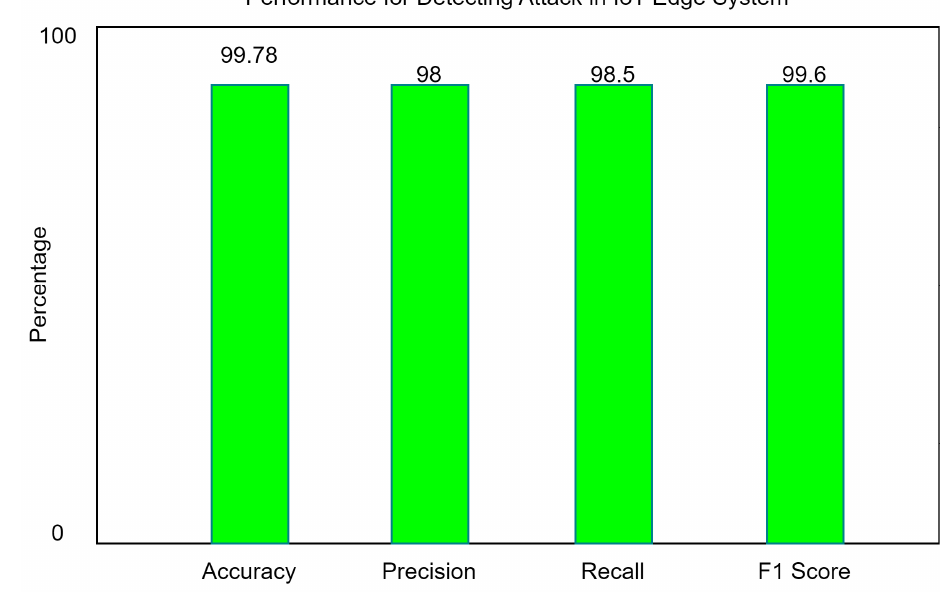
Figure 8. Hybrid classification model performance.